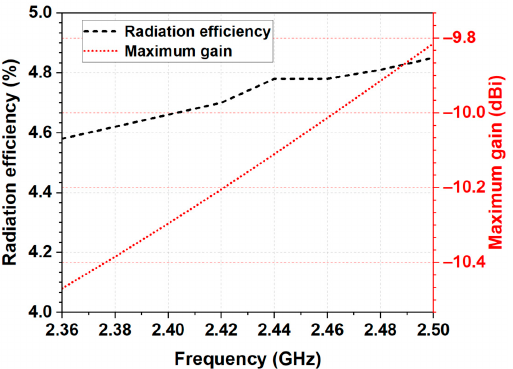
Figure 5. Radiation efficiency and maximum gain of the proposed antenna on Phantom 2 (shown in Figure 3).